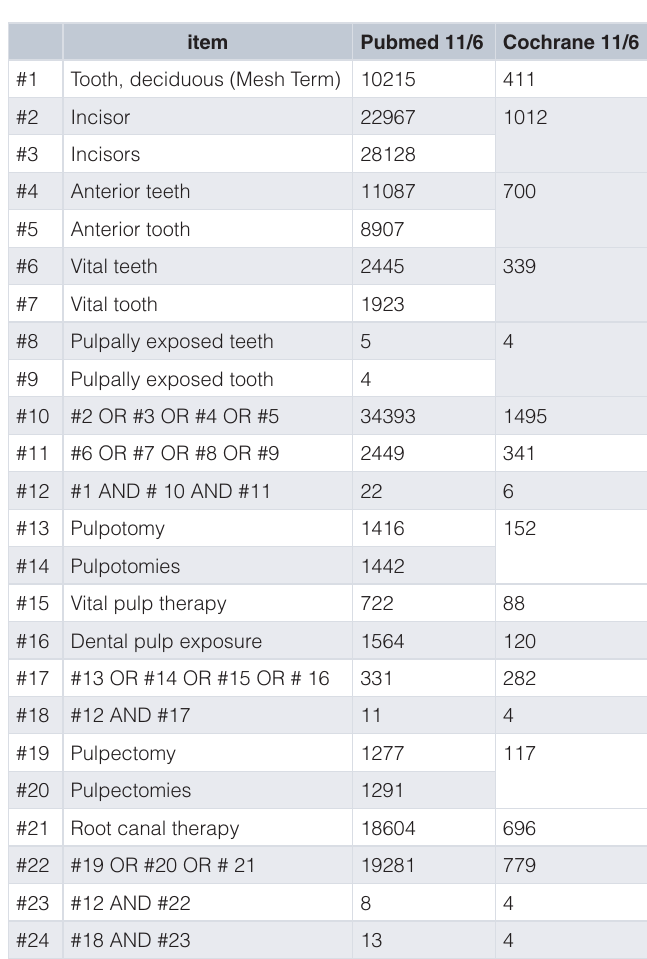
Table 2. Detailed search strategy for Pubmed and Cochrane library.